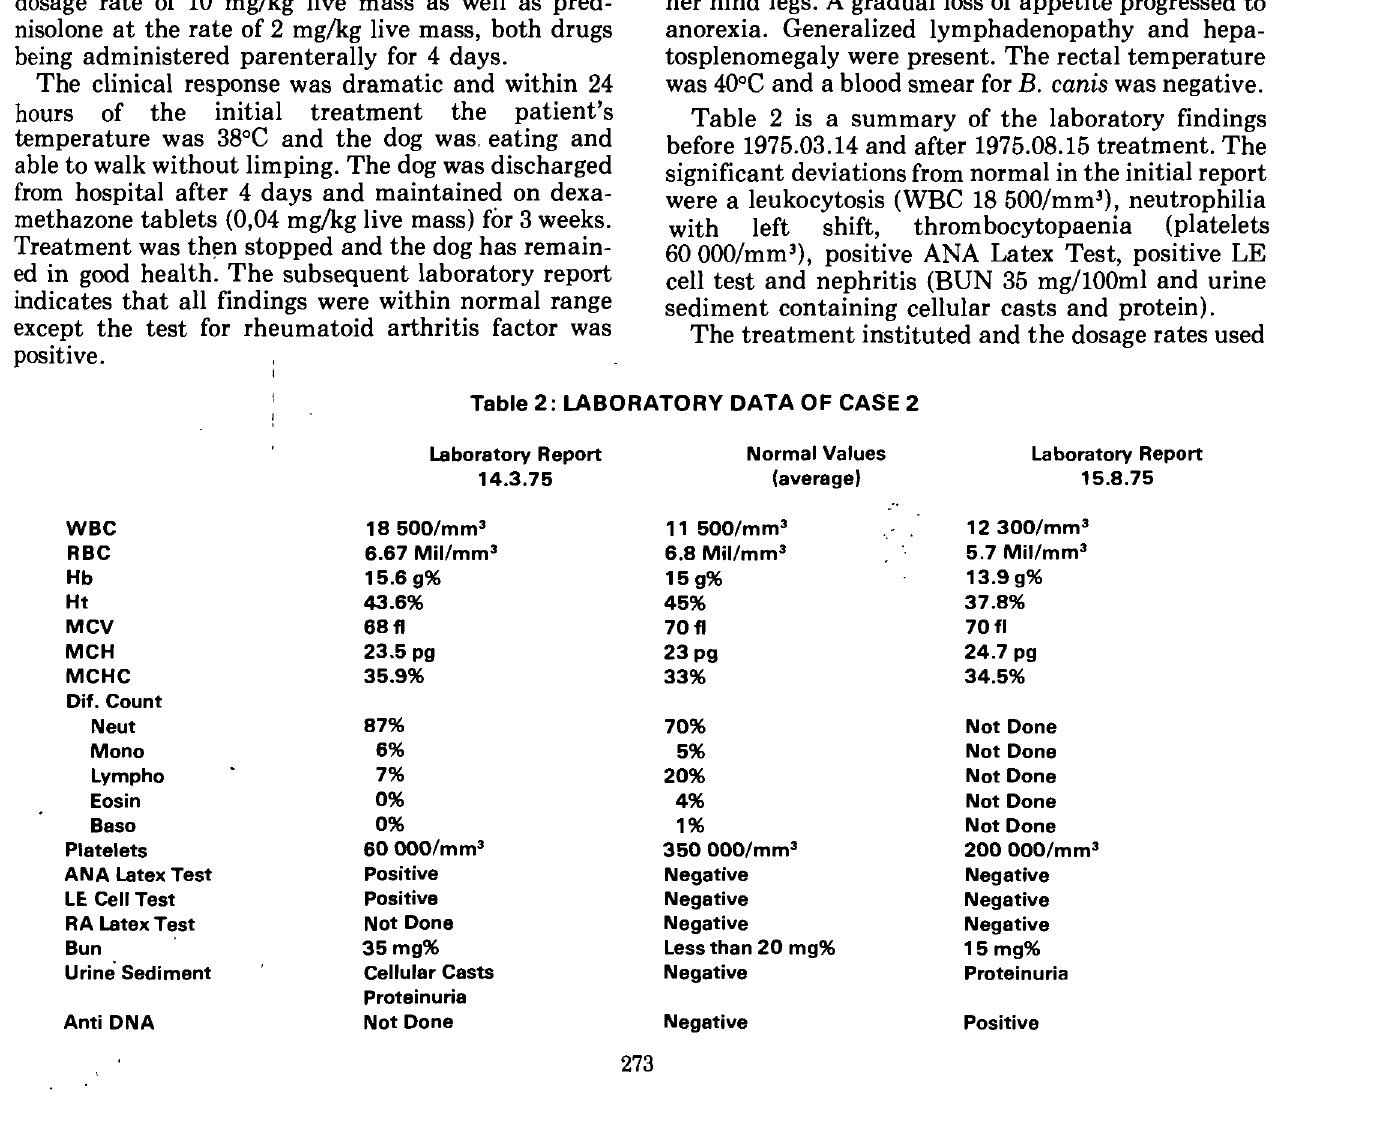
Table 2: LABORATORY DATA OF CASE